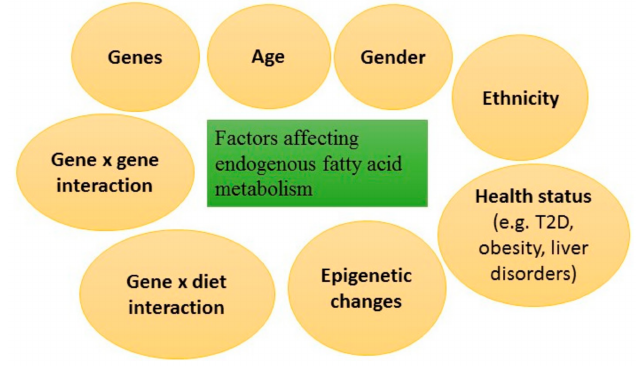
Figure 1. Factors affecting endogenous fatty acid metabolism. T2D, type 2